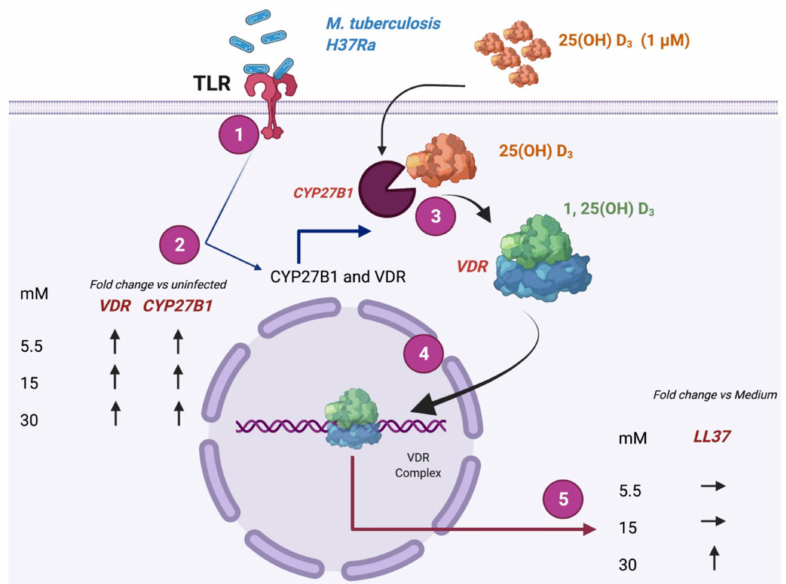
Figure 5. Overview of the effect of high glucose concentrations on LL37 expression dependent on Vitamin D. 1. Recognition of M. tuberculosis by Toll-like receptors (TLRs). 2. Induction of NF-kB activation and induction of CYP27B1 and vitamin D receptor (VDR) enzymes. 3. Conversion of vitamin D 25(OH)D 3 into its active form 1, 25(OH)D 3 by CYP27B1 and recognition by the VDR. 4. translocation of the VDR complex to the nucleus. 5. Induction of LL37 expression. Effect